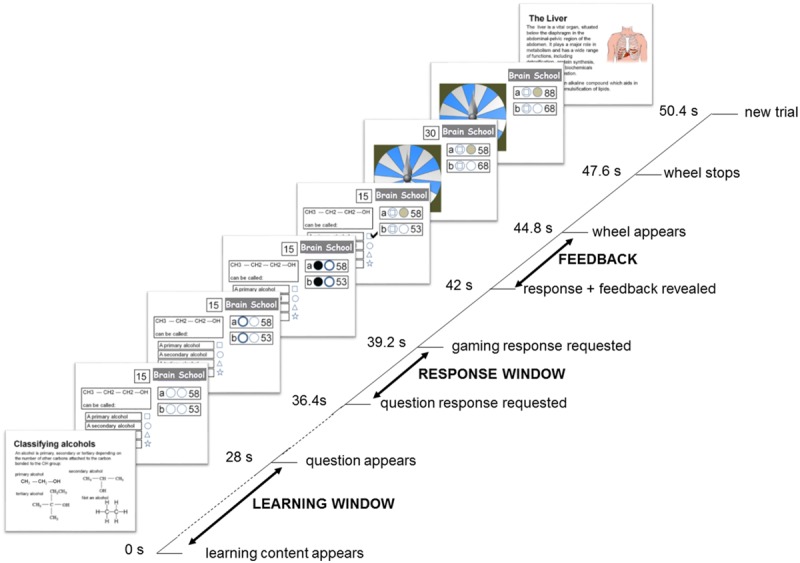
Trial timeline for the Games-based condition, with main epochs of interest indicated in capitals. In this condition, participants were asked to study the learning content carefully (which was presented twice in the block to encourage rehearsal, but always with a novel question) before answering a question in return for points that could be doubled or lost on a wheel of fortune. At the same time, a competitor in the control room was trying to accumulate points in the same way. Responses of participant and competitor were hidden from each other until the correct answer was revealed, and both were required to decide whether they would be gaming on the wheel of fortune, should their answer be correct, before this outcome was known. The points available for a correct answer escalated over the block from 1 to 19. The duration of each trial was 50.4 s resulting in each the three conditions of 20 trials lasting 16 min and 48 s and, allowing for a momentary pause between conditions, a total functional scanning time of approximately 51 min.